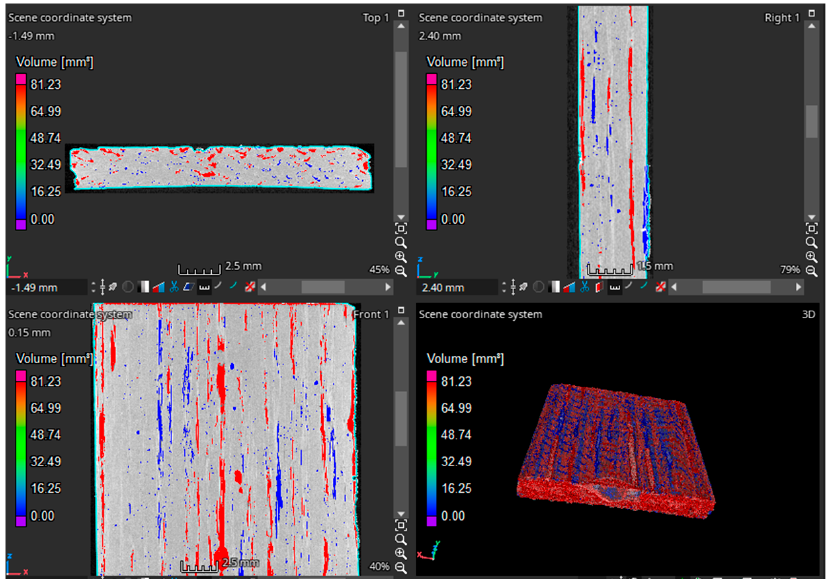
Figure 4. Micro CT imaging of composites.